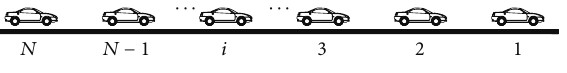
Figure 1: Platoon of 𝑁 cars running on a single